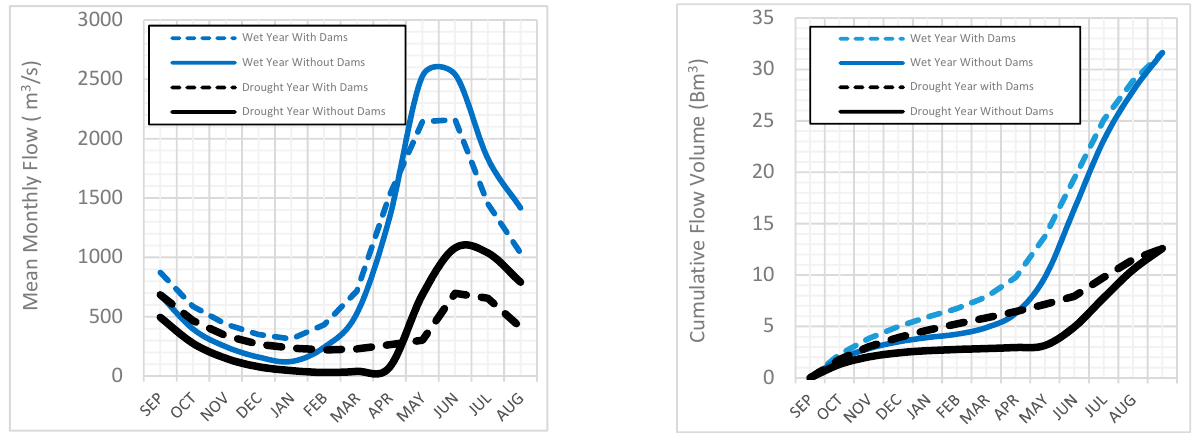
Figure 5. Mean monthly flow ( left ) and cumulative flow volume ( right ) at the Dakah Station for sample wet year (1991) and dry year (2002) with and without dams.